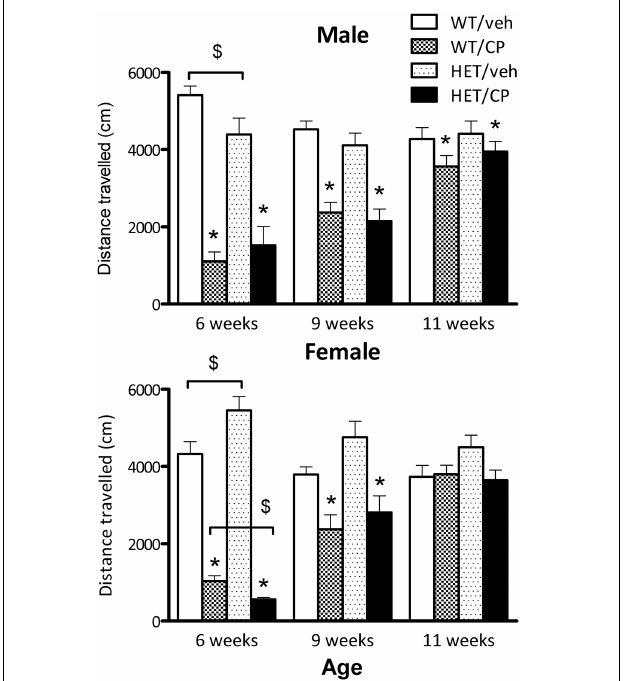
FIGURE 1 | Total distance traveled (cm) by male and female mice in automated photobeam cages at the start of CP55,940 (CP) treatment at 6 weeks of age, end of CP treatment at 9 weeks of age and 2 weeks after treatment had ceased. Wild-type and HET mice were either treated with vehicle solution or CP from 6 to 9 weeks of age. CP treatment significantly reduced distance traveled in the first and second session in both sexes and distance traveled was still slightly, but significantly reduced in male mice 2 weeks after treatment had ceased (for statistical analysis see text). Additional effects between groups of animals analyzed with pairwise comparison are indicated in the figure: ∗ P < 0 . 05 for differences between vehicle-treated controls and CP-treated mice based on main effect of CP in ANOVA. $ P < 0 . 05 for difference between genotypes based on pair-wise post-hoc